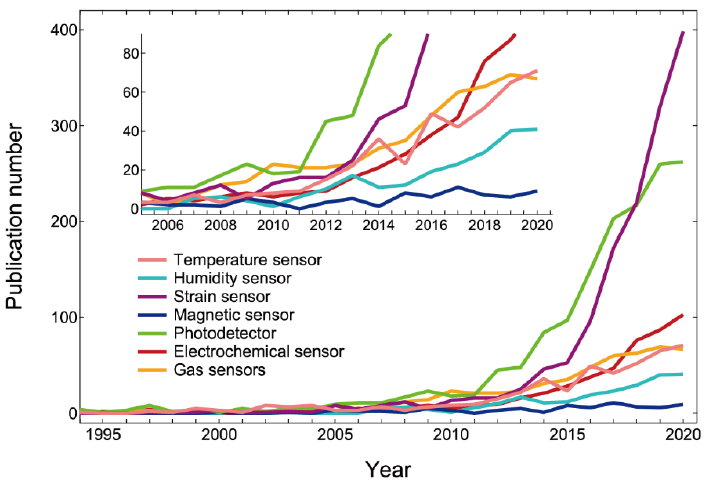
Figure 2. A change in the publication numbers of various types of flexible sensors.